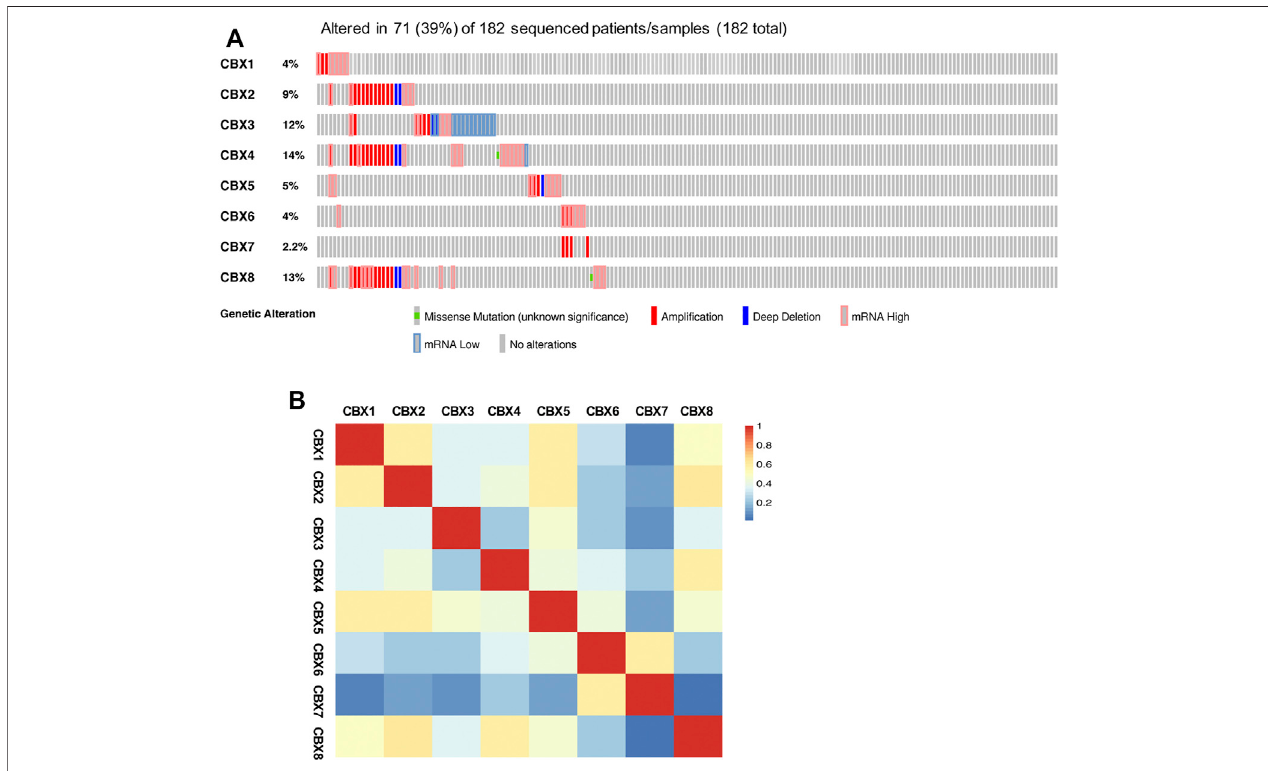
FIGURE 7 | Genetic alterations and correlation analysis of distinct CBXs members in OV. (A) Summary of the alteration rates for CBX1-8 in OV (cBioPortal). (B) Correlation between eight CBXs family members in OV (GEPIA2).